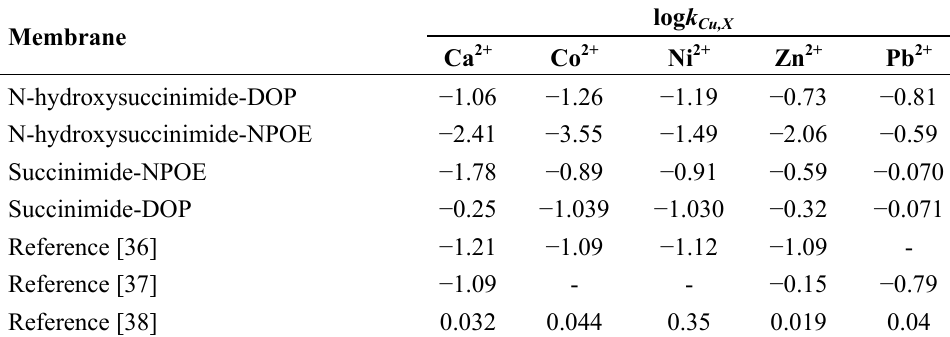
Table 2. Selectivity coefficients of PVC membranes evaluated in this work.